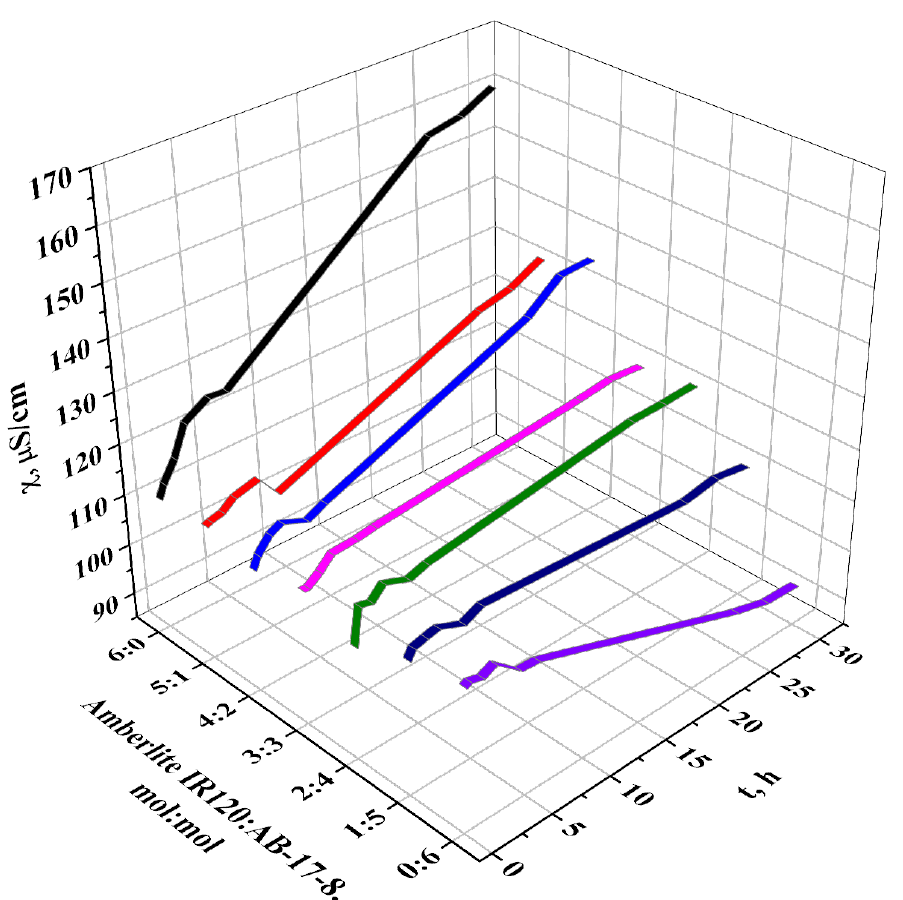
Figure 2. Specific electric conductivity of europium nitrate in dependence from molar ratios of ion exchangers and time.